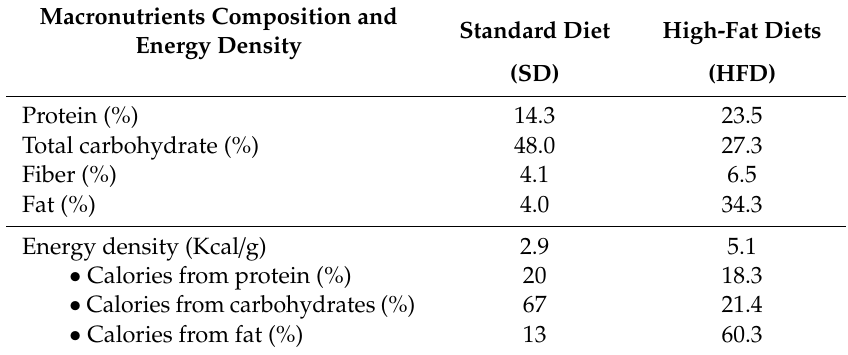
Table 1. Macronutrient profile of standard diet and high-fat diets used throughout the study. Macronutrients Composition